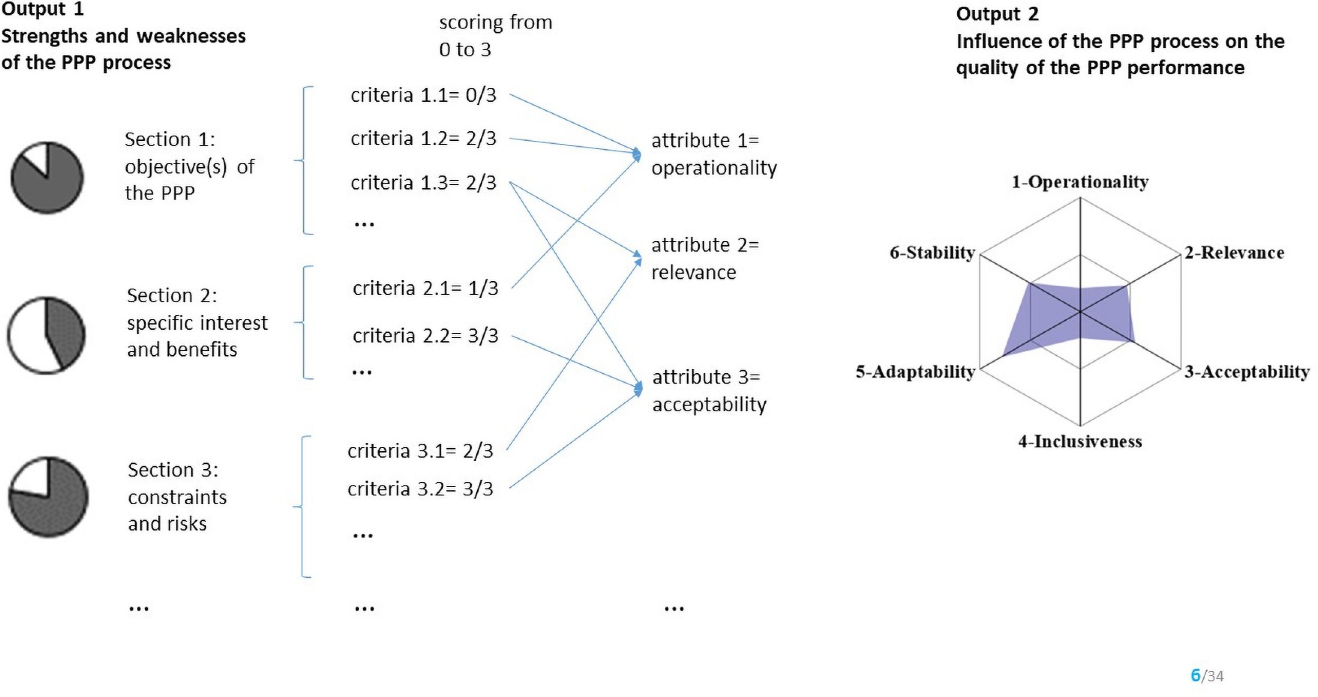
Fig 2. Principle of the scoring process used in the tool, allowing two graphic outputs. The graphic output 1 (the strengths and weaknesses of the structure of the process) represents the assessment of the ten sections using a set of evaluation criteria. The graphic output 2 (the influence of the process on the quality of the public- private partnership performance) represent the assessment of the six quality attributes, influenced by evaluation criteria. The scores of the evaluation criteria have been randomly assigned. PPP: public-private partnership.